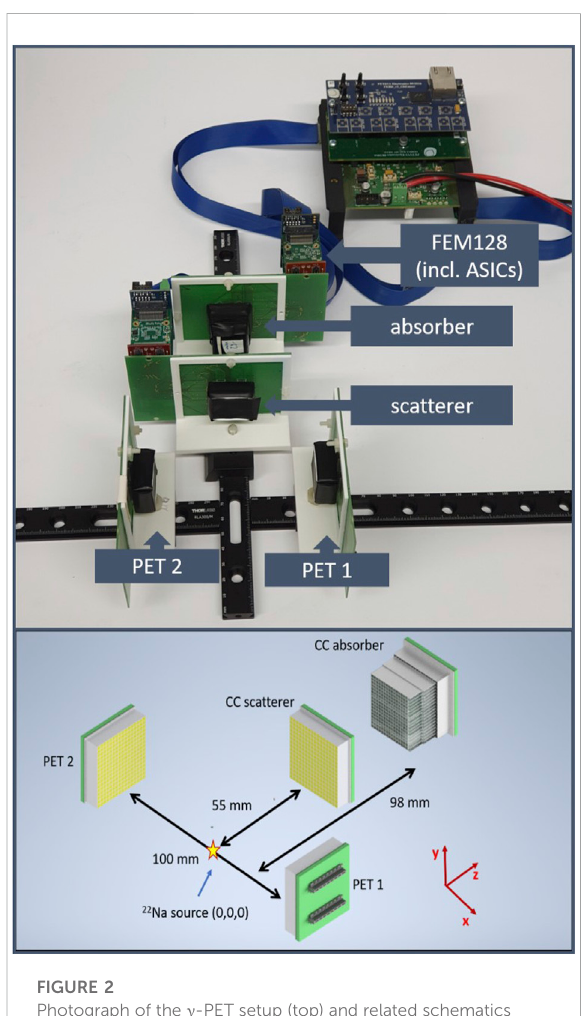
FIGURE 2 Photograph of the γ -PET setup (top) and related schematics including the dimensions and distances